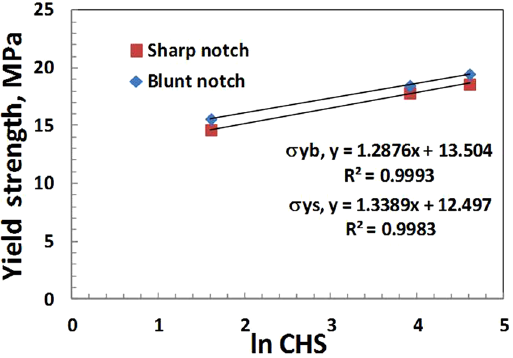
Figure 7. Plot of Yield strength of sharp and blunt crack HDPE as a function of ln CHS at 45 °C.